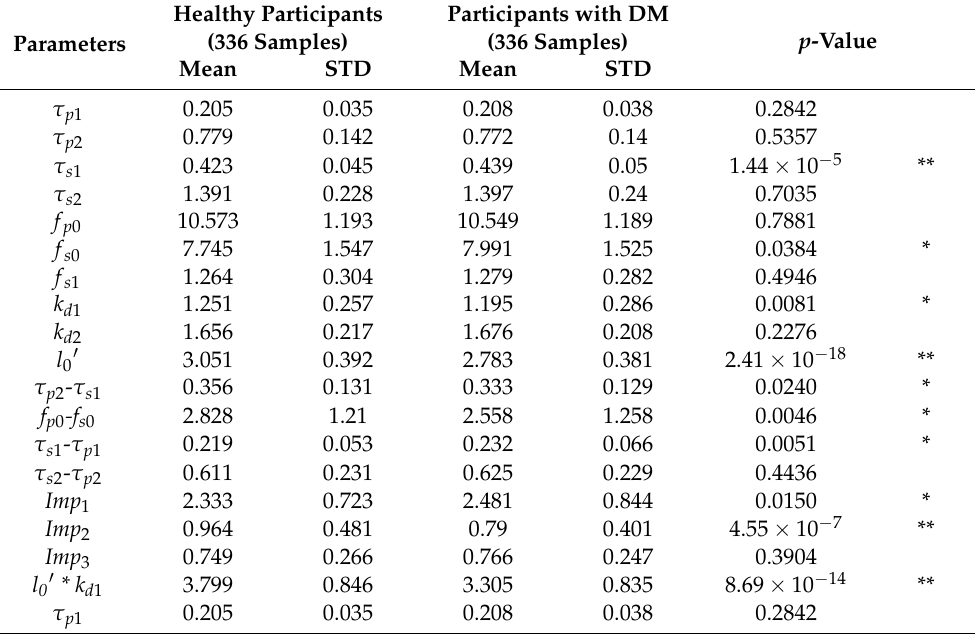
Table 7. Statistical results of the parameters between participants with and without diabetes mellitus. Healthy Participants Participants with (336 Samples) Parameters